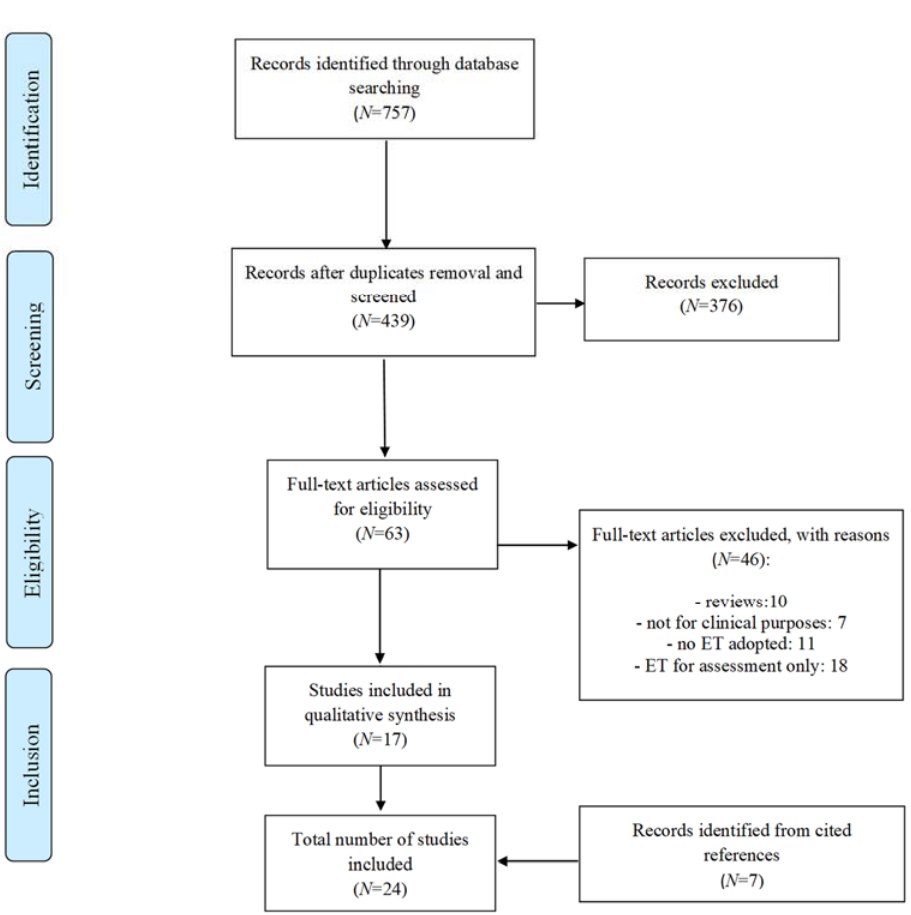
Figure 1. PRISMA flow-chart displaying study selection process. Diagram adapted from Moher et al. (2009).